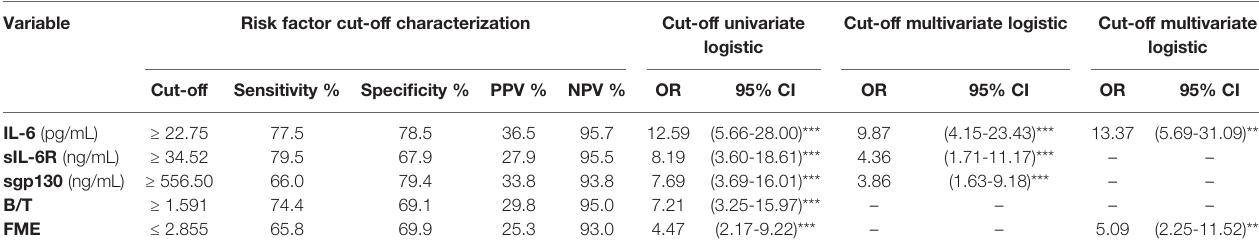
TABLE 1 | Univariate and multivariate logistic regression analyses of IL-6 signalling components as predictors of COVID-19 severity (without death). Variable Risk factor cut-off characterization Cut-off univariate